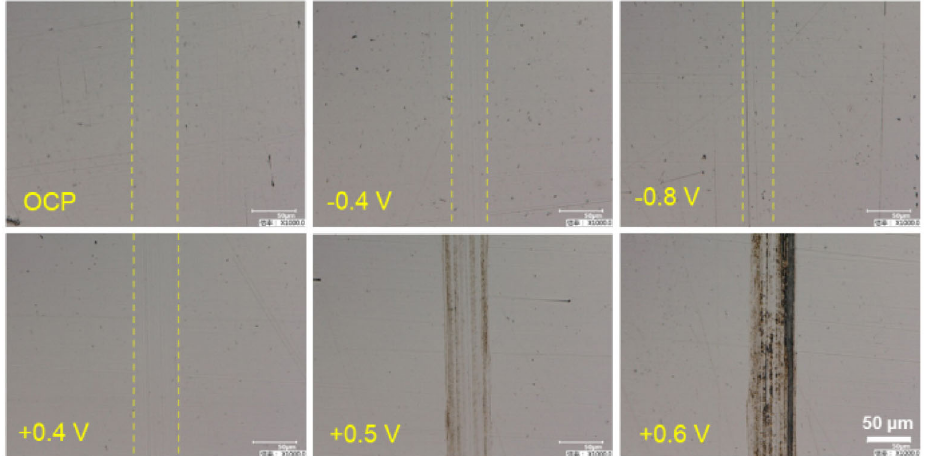
Fig. 7 Surface morphologies of the wear tracks on Pt plate with 0.001 mM SDS aqueous solution as lubrication under different applied surface